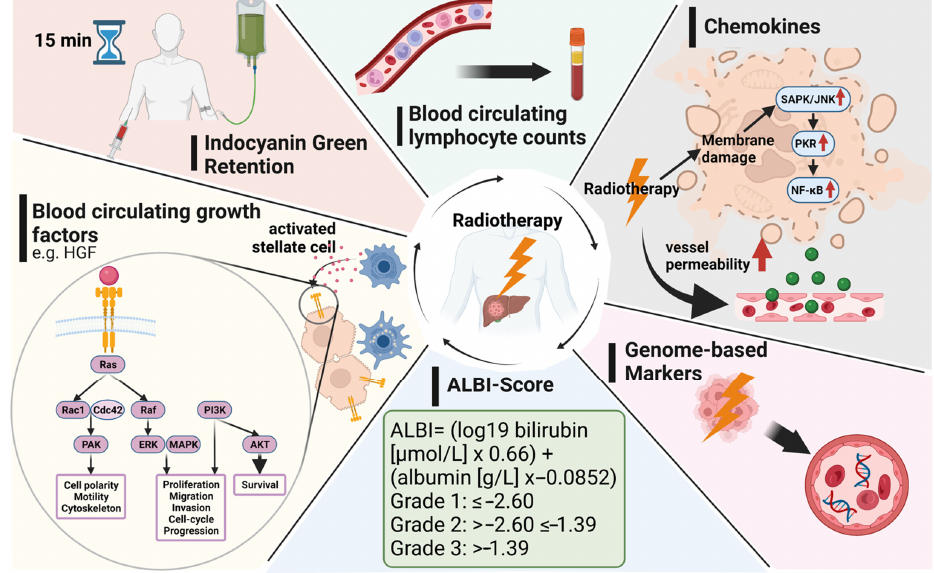
Figure 1. Potential candidates for prognostic and predictive biomarkers in patients with liver malignancies undergoing radiotherapy. HGF, hepatocyte growth factor; RAS, rat sarcoma; Rac1, Ras-related C3 botulinum toxin substrate 1; Cdc42, cell division cycle 42; RAF, rat fibrosarcoma; ERK, extracellular-signal regulated kinase; MAPK, mitogen-activated protein kinase; PI3K, phosphoinositide-3 kinase; AKT, protein kinase B; SAPK/JNK, stress-activated protein kinase/c-Jun NH(2)-terminal kinase; PKR, protein kinase R; NF-kB, nuclear factor kappa-light-chain-enhancer of activated B cells. This figure was created with BioRender.com.